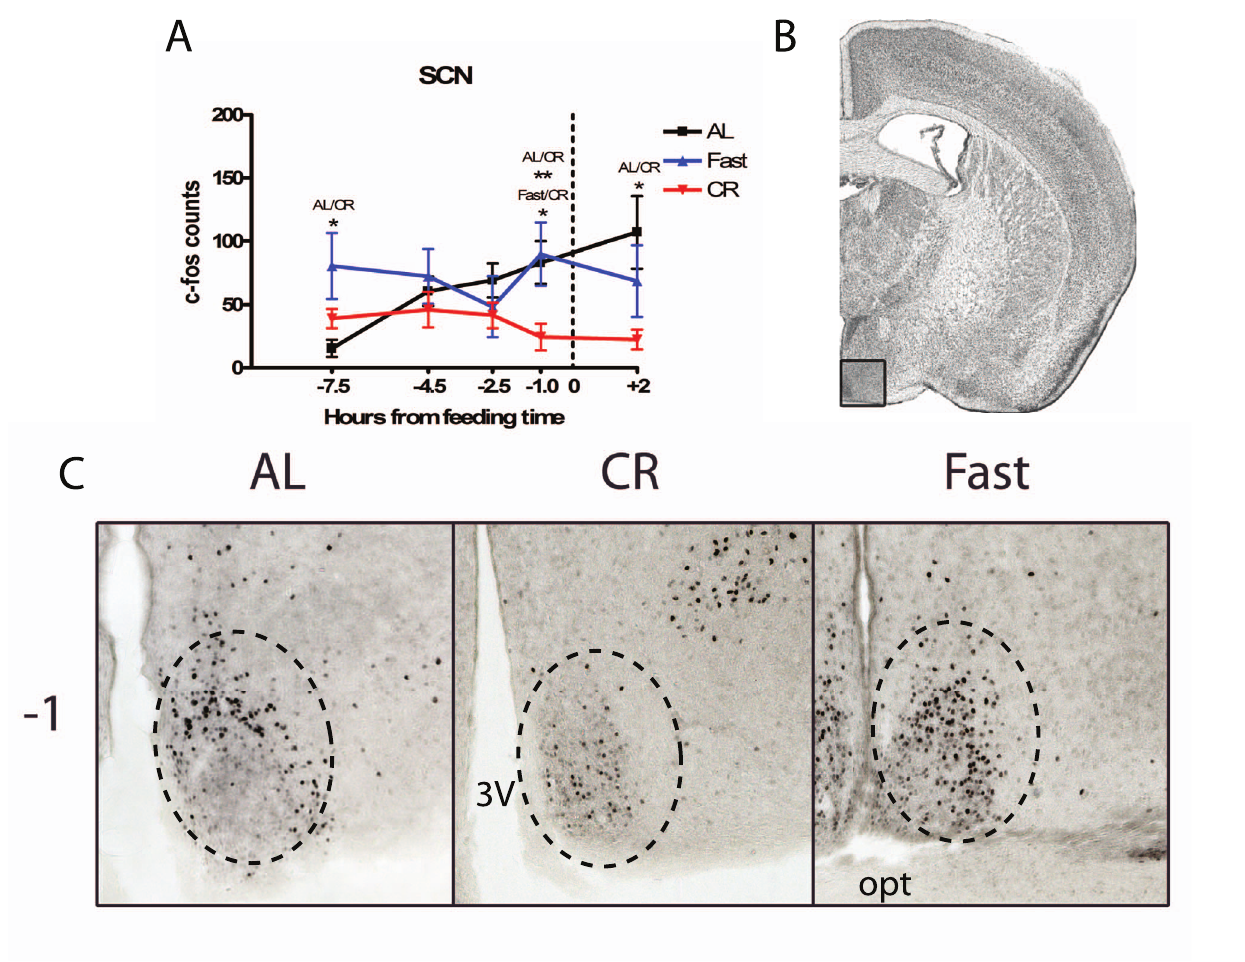
Figure 6. c-Fos protein expression in the in the suprachiasmatic nucleus (SCN) of calorie-restricted, acutely fasted, and AL control mice. (A) Mean ( 6 SEM) number of c-Fos-immunoreactive nuclei in the SCN of AL controls, fasted, and CR at 5 time points measured relative to feeding. (B) Representative coronal brain map with Nissl stain showing location of region under study adapted from Paxinos and Franklin. (C) Representative micrographs at TP 2 1 of FOS expression in the SCN. Sample sizes for TP 2 7.5 thru + 2 are n=6, 11, 12, 8, 6 for AL groups, n=5, 12, 11, 11, 6 for CR groups, and n=6, 6, 6, 6, 6 for Fast groups.